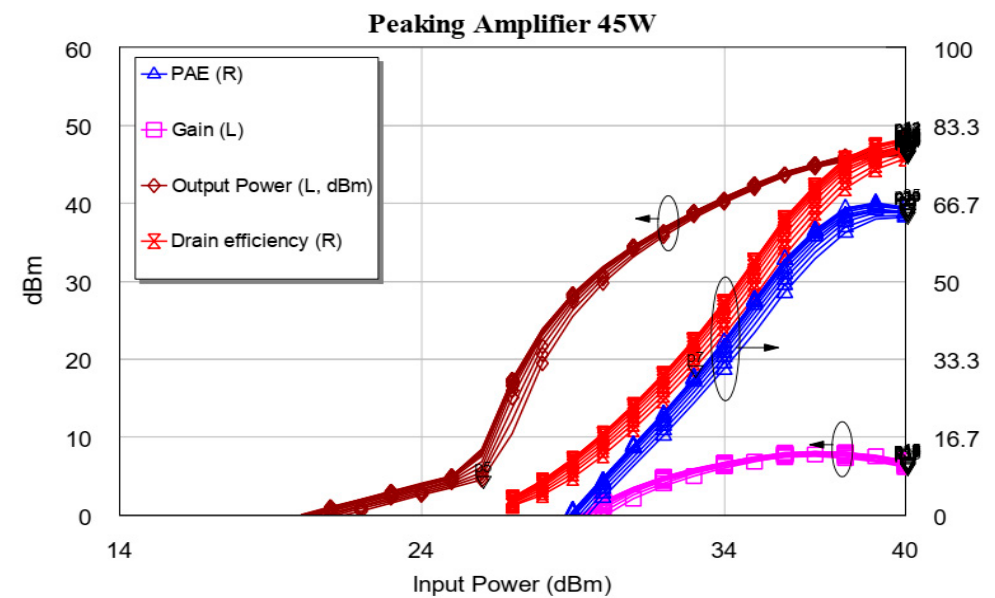
Figure 8. Peaking amplifier performance.